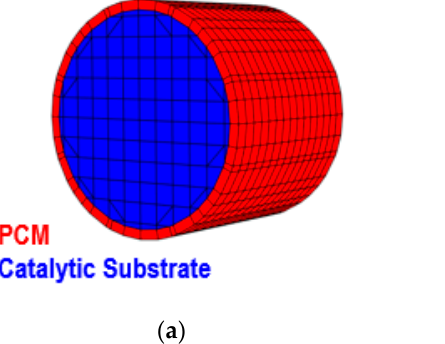
Figure 16. Effect of external and internal PCM configuration on the thermal field of a monolith during a cool-down process under zero flow conditions.